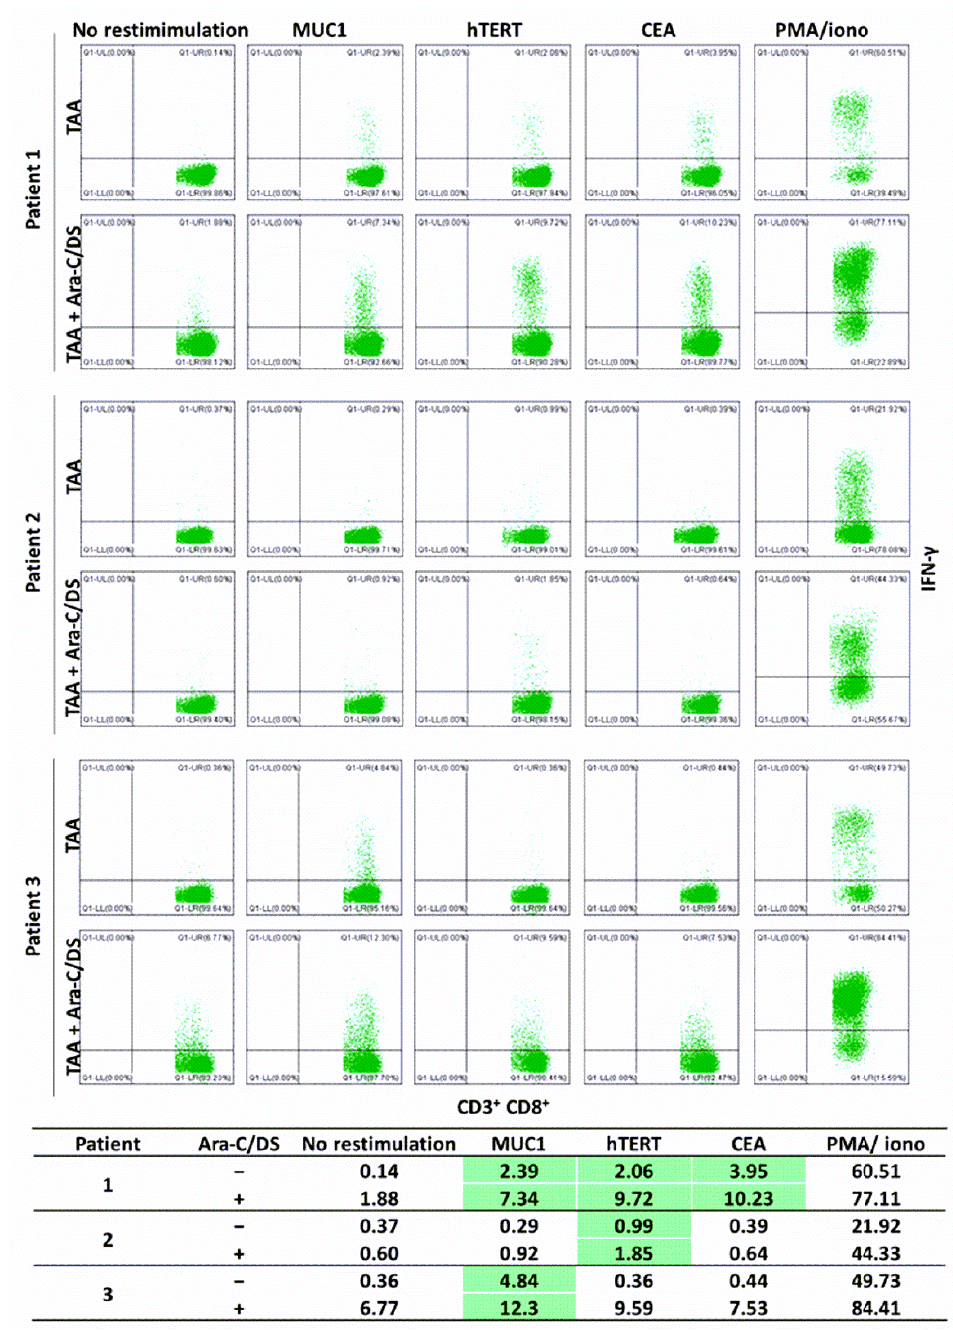
Figure 9. TAA-specific IFN- γ + CD8 T cell responses in PBMC from 3 colorectal cancer patients. PBMC were incubated with TAA PepMix with or without Ara-C/DS (100 nM Ara-C, 2 µ g/mL DS) and re-stimulated with TAA PepMix on day 12. After 12 h, CD8 T cells were analyzed for intracellular IFN- γ by flow cytometry. PMA/ionomycin was used as a positive control and unstimulated cells were used as a negative control. IFN- γ + CD8 + percentages are summarized in the table where responders are highlighted in green.